Question: Condense the content of this figure into a single sentence.
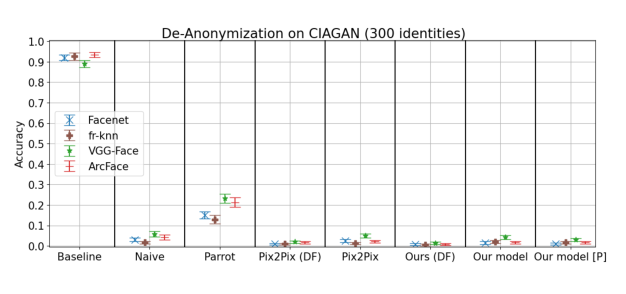
Answer: Recognition accuracy for CIAGAN, given for base- line, naive, parrot, de-anon. via Pix2Pix trained on DigiFace- 1M, via Pix2Pix, via our model trained on DigiFace-1M, via our model; on 300 identities of CelebA.